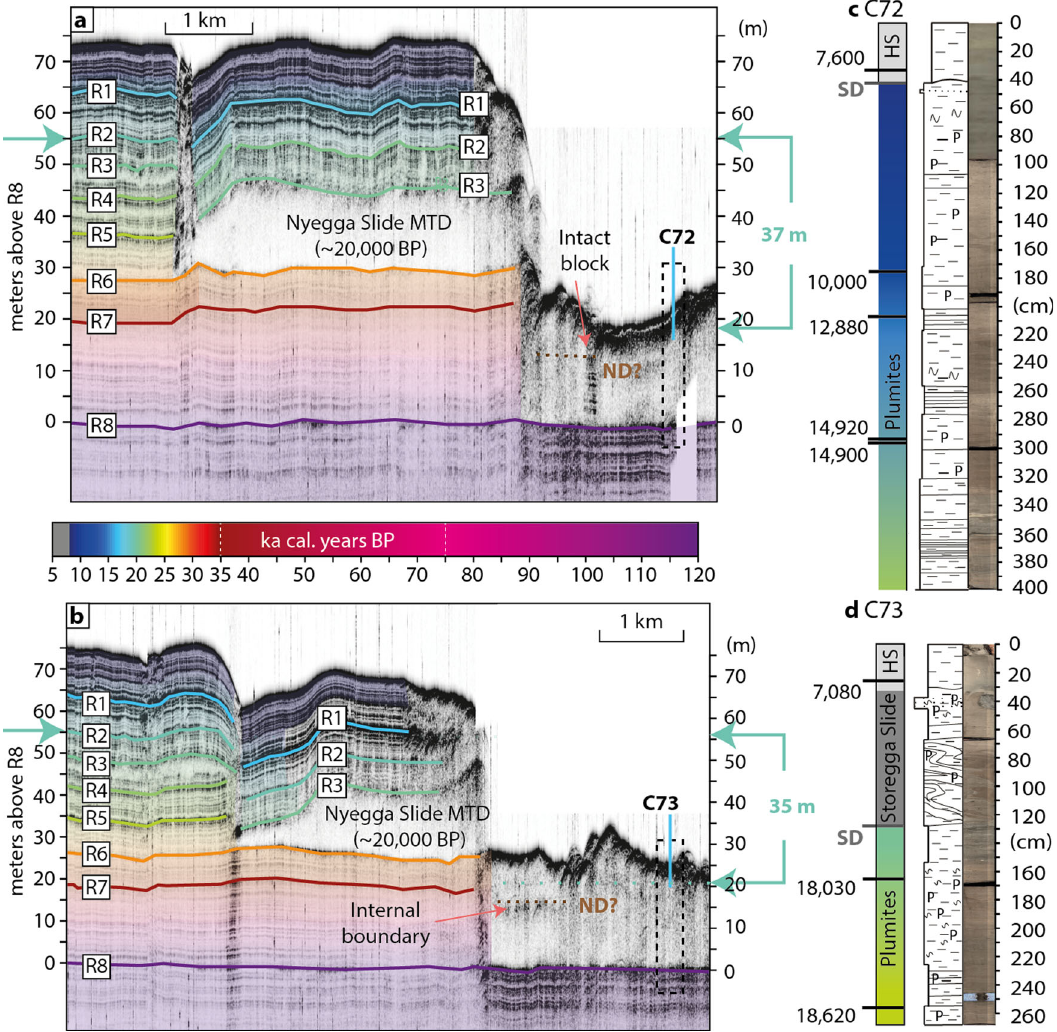
Fig. 5 Integration of the sidewall seismostratigraphy with sediment core chronostratigraphy from the north-eastern slide scar. a and b Flattened versions of the echosounder pro fi les from Fig. 3. The fl attened pro fi les show a partly buried ~20,000 BP Nyegga Slide MTD, the projected sediment core locations, and the slide scar in fi ll with indications for an internal boundary (Nyegga discontinuity, marked with ND), and the key horizons R1 to R8. Semi- transparent colour overlays in panels a and b illustrate the age depth model within the sediments (see colour bar between panels a and b). c and d Sediment cores C72 and C73 with radiocarbon sample (calendar ages). SD marks the Storegga Slide Discontinuity. Colours again correspond to the colour bar between panels a and